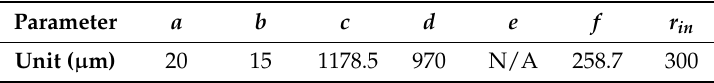
Table 3. Dimensional parameters of the Leads layer.